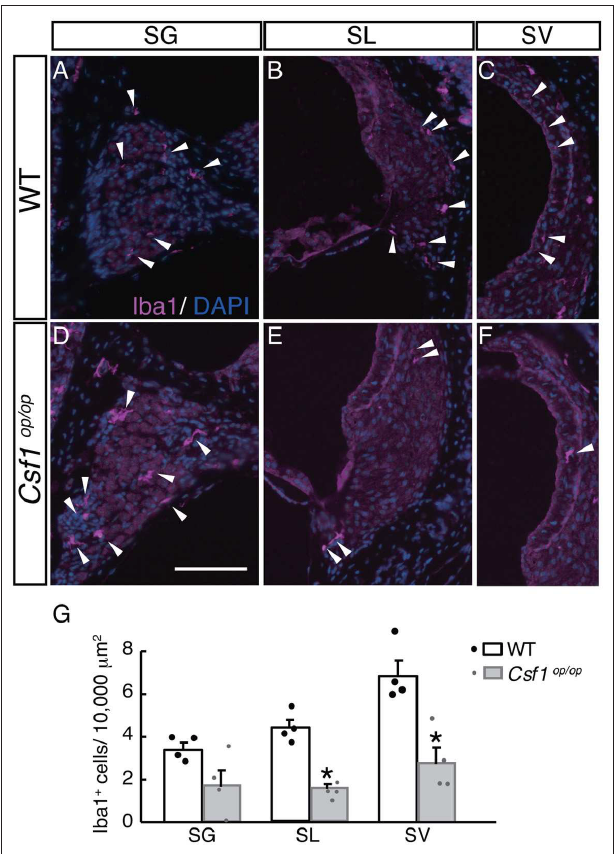
FIGURE 4 | Distribution and density of Iba1-positive macrophages in each part of the cochlea of wild type and Csf1 op / op mice. Iba1-positive macrophages are found in the spiral ganglion (A,D) , spiral ligament (B,E) , and intermediate cell layer of the stria vascularis (C,F) in both wild type ( WT ) and Csf1 op / op mice at the age of 4 weeks. While there is no statistically significant difference in the density of Iba1-positive macrophages in the spiral ganglion, a significant reduction in the density of Iba1-positive cells is observed in Csf1 op / op mice, suggesting Csf1 dependency of resident macrophages in the spiral ligament and stria vascularis ( G , single plots are also shown; n = 4 for each genotype). Bar: 200 µ m for (A–F) (shown only in D ). * p < 0.05. 4-week old WT and Csf1 op / op mice. Non-sensory parts of